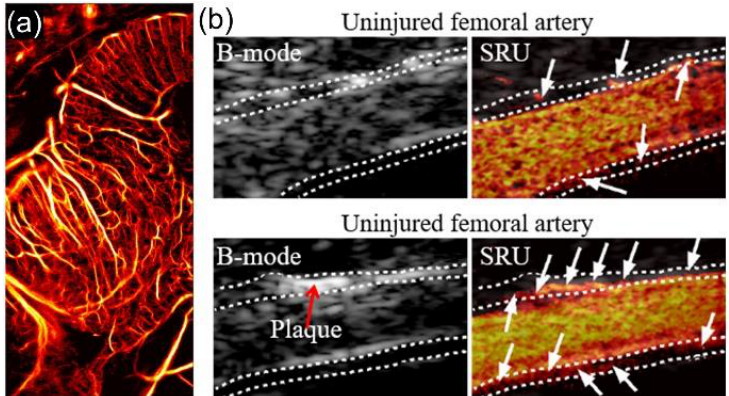
Figure 8. Representative SRU images of microvasculature in chicken embryo brain (Reprinted with permission from Ref. [86]. Copyright 2020 Springer Nature) ( a ), and VV in uninjured (upper panel) and injured (lower panel) rabbit femoral arteries (Reprinted with permission from Ref. [90]. Copyright 2020 IEEE) ( b ).